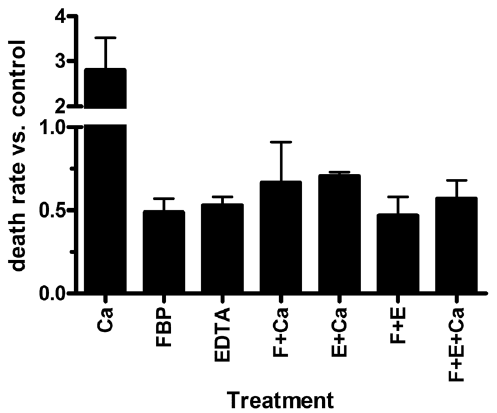
Figure 2. Effects of calcium and EDTA on hypothermic preservation of cardiac myocytes. Cells were incubated with no additions or with 100 m M calcium, 5 mM FBP, 0.5 mM EDTA, or various combinations of additions. Death rates for treated cells were normalized to those of control cells. The averages of the relative death rates for two experiments are plotted, with error bars indicating S.E.M.